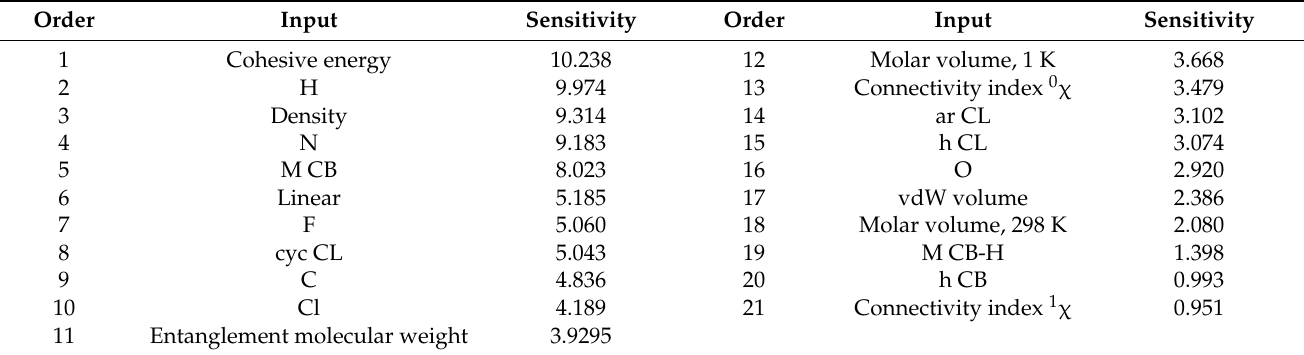
Table 2. Sensitivity analysis for the best model in Case